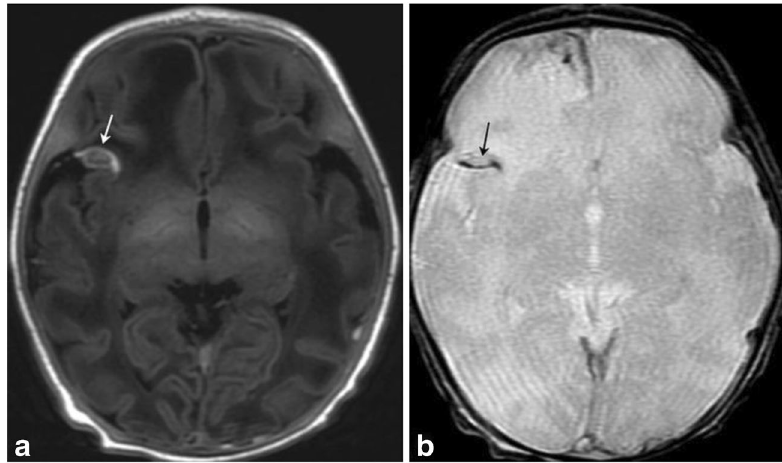
Fig. 9 Subarachnoid hematoma Axial T1/GRE MRI in a 9-day-old term neonate with history of difficult, vacuum- assisted delivery. Right frontal blood is noted in a gyriform distribution, suggesting subarachnoid blood. Subdural blood was also noted tracking along the falx